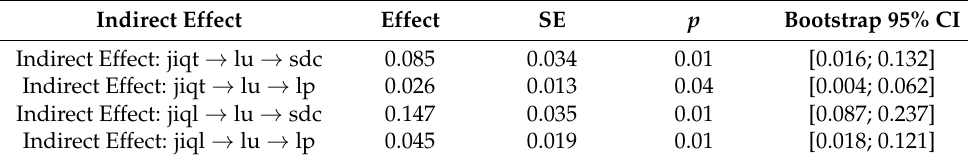
Table 7. Decomposition of Indirect Effects of the mediated model.